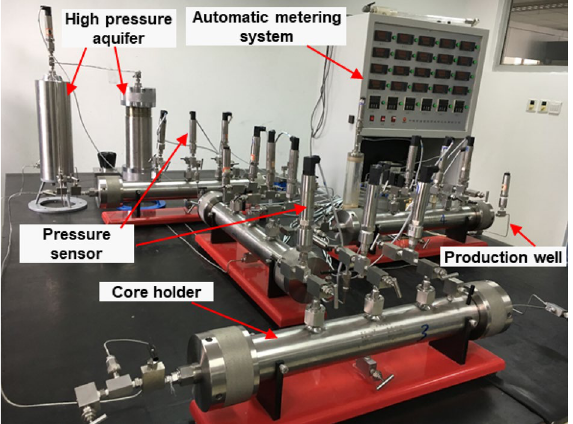
Figure 4. Joint water-control experimental setup for fractured water drive gas reservoirs.